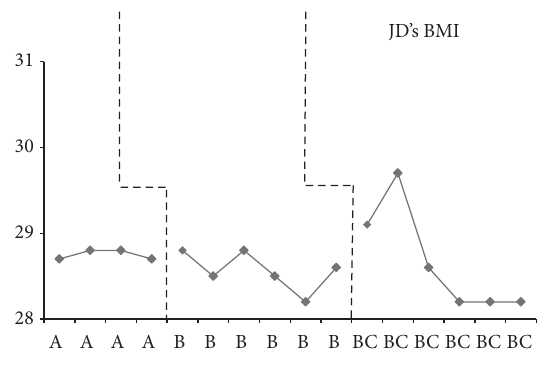
Figure 3: JD’s BMI across all phases.